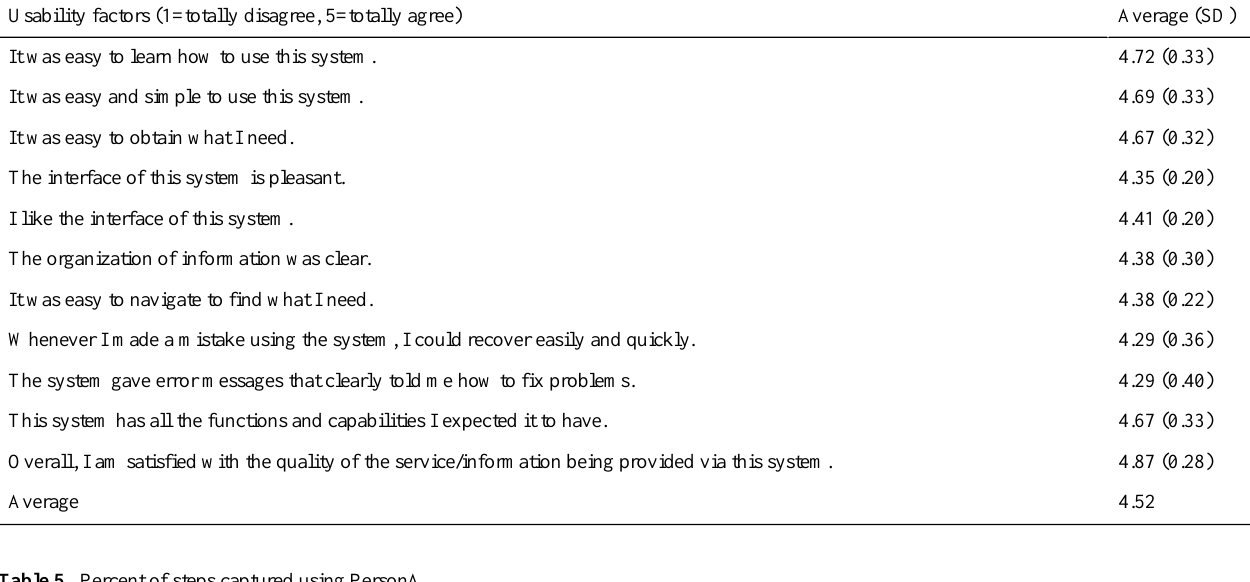
Table 4. Quantitative results for overall usability.